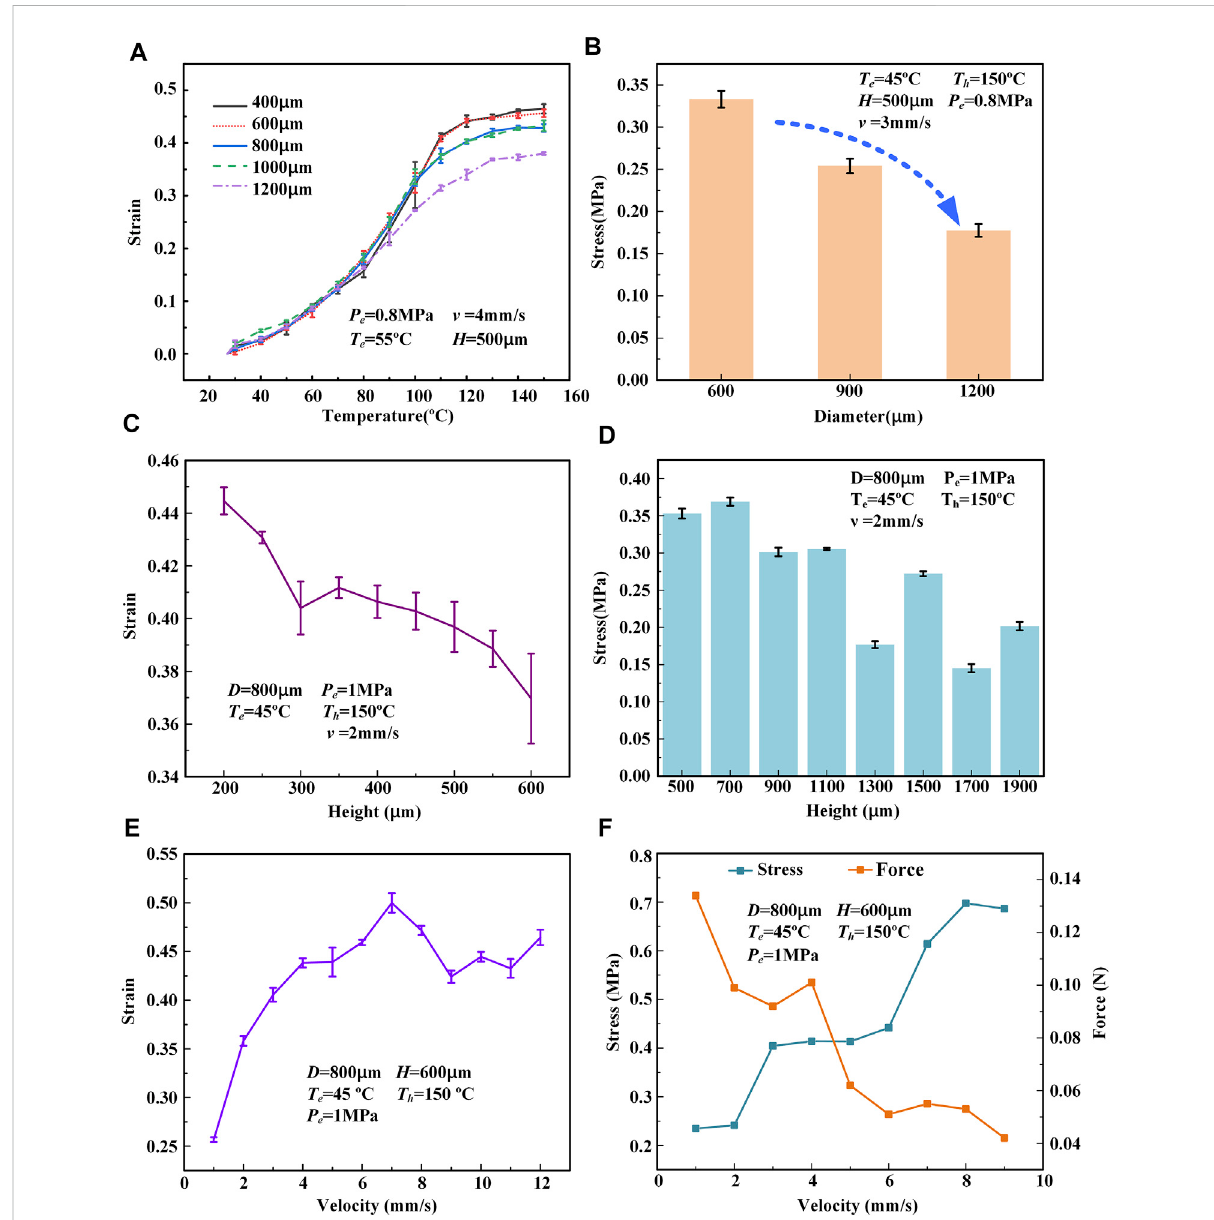
FIGURE 3 Actuation performance of printed LCE fi laments under various printing parameters ( T e stands for the printing temperature at which the LCE is heated in the barrel during printing, T f indicates the temperature at which the printed LCE is heated, and P e is the extrusion pressure.) (A) The relationship between the actuation strain of a printed LCE fi ber (when heated to different set temperatures) and the nozzle diameter D (B) The relationship between the actuation stress of the LCE fi ber (when heated to 150 ° C) and nozzle diameter D (C) The relationship between the actuation strain of printed LCE fi ber (when heated to 150 ° C) and the printing height H (D) The relationship between the actuation stress of the LCE fi ber (when heated to 150 ° C) and printing height H (E) The relationship between the actuation strain of the printed LCE fi ber (when heated to 150 ° C) and printing speed v. (F) The relationship between the actuation stress and the actuation force (when heated to 150 ° C) of the printed LCE fi ber and printing speed